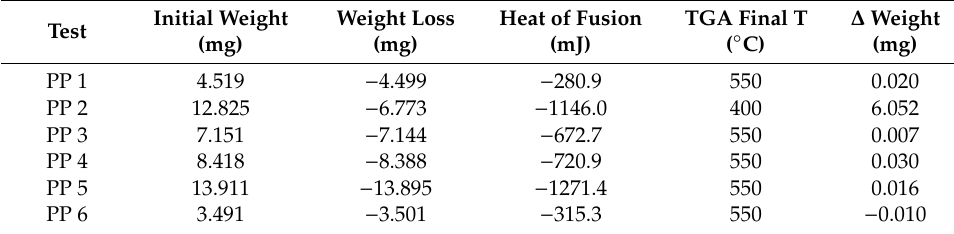
Figure 7. Calibration curve relating the PP heat of fusion to the amount of pure PP. Table 4. TGA analysis on pure PP samples.